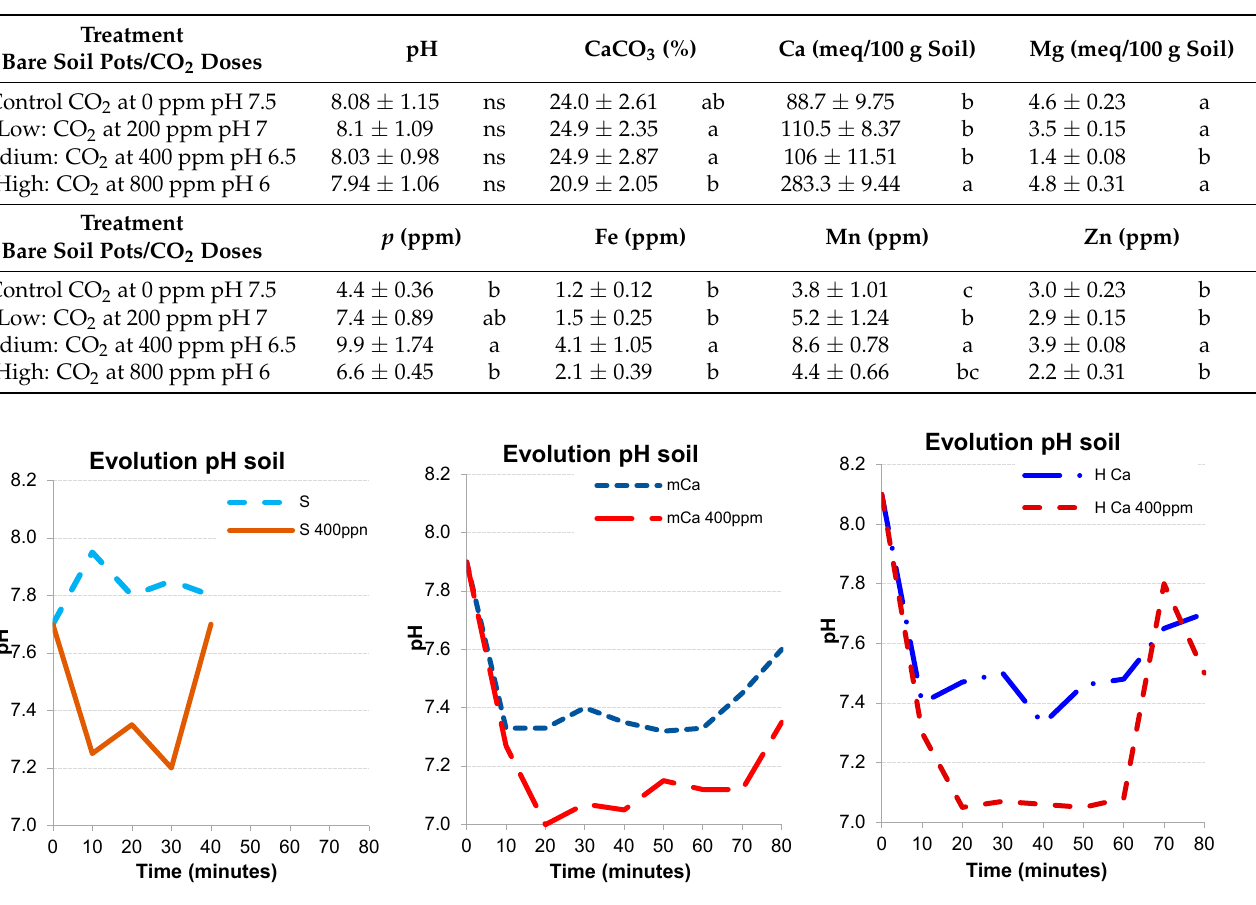
Figure 1. Evolution of the soil pH after irrigation with carbonated water in pots without plants and with 3 substrates. Treatments: schist neutral soil (S), clay medium calcareous soil (m Ca), and highly calcareous soil (H Ca) treated with non-carbonated water (pH 7.5) and 400 ppm CO 2 -carbonated water (pH 6.5).